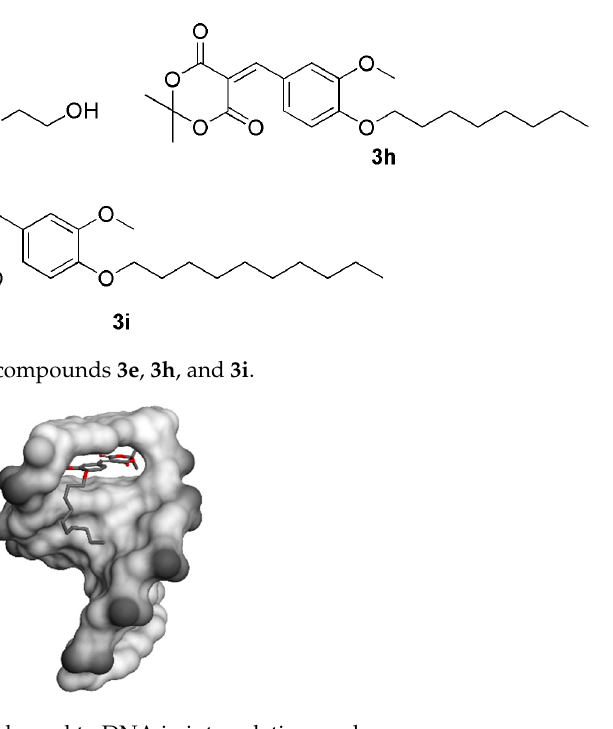
Figure 2. Compound 3i bound to DNA in intercalative mode.